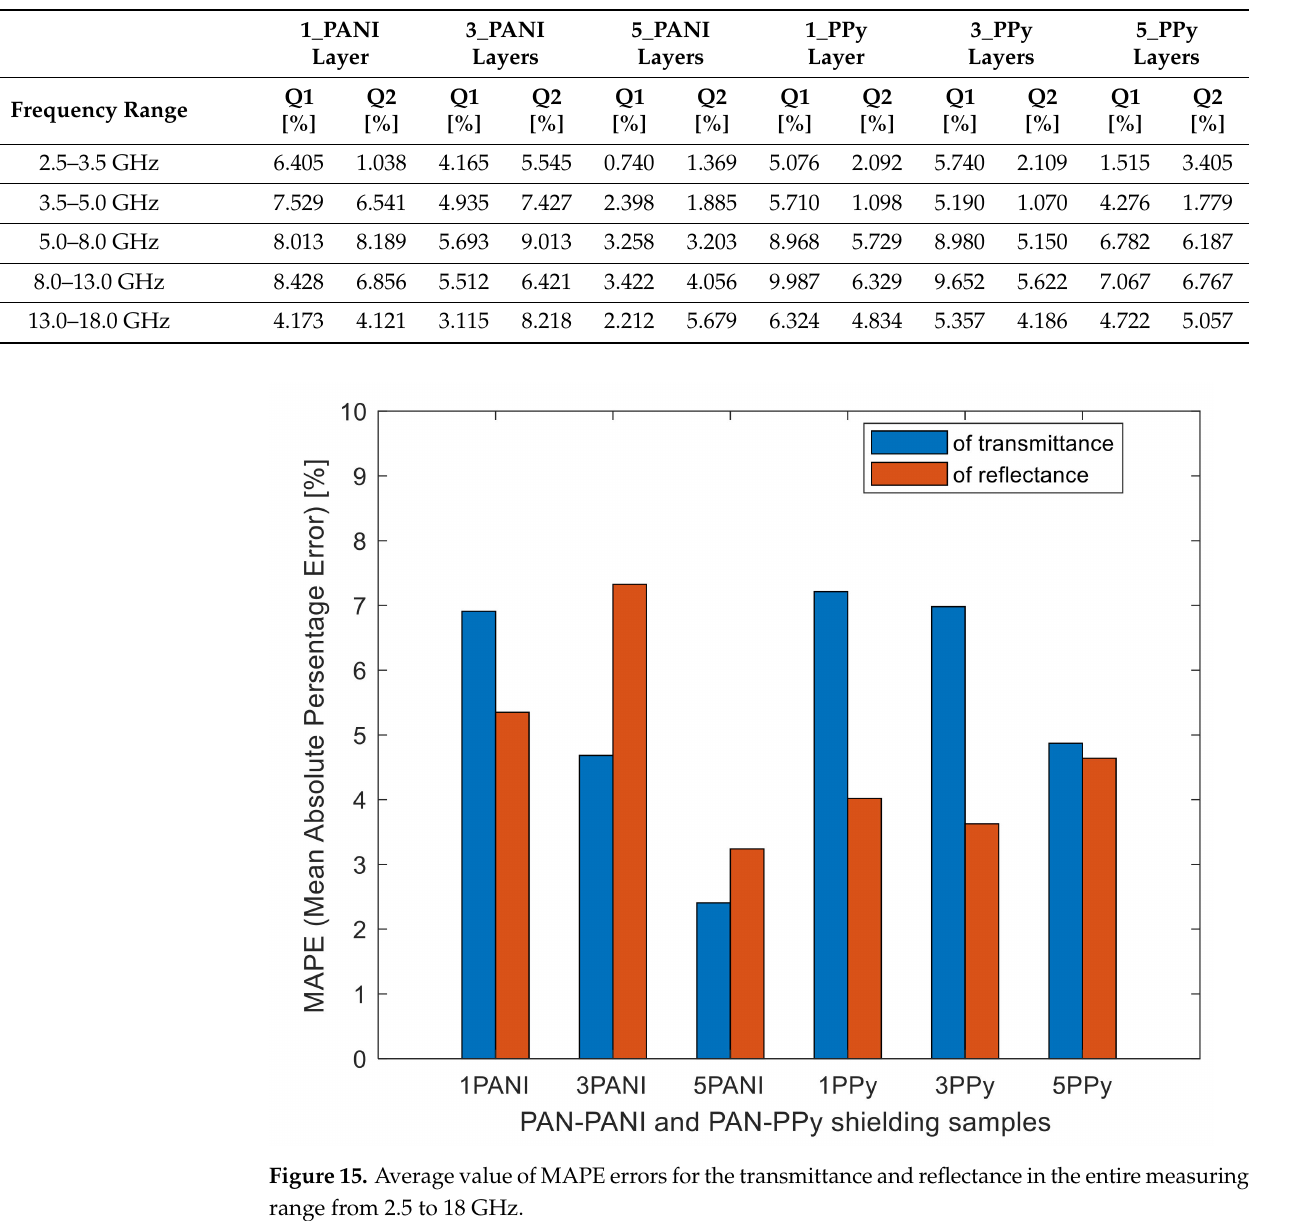
Table 4. List of MAPE (mean absolute of percentage error) errors for all samples of shielding materials in individual measurement ranges: Q1—MAPE of the transmittance factor, Q2—MAPE of the reflectance.